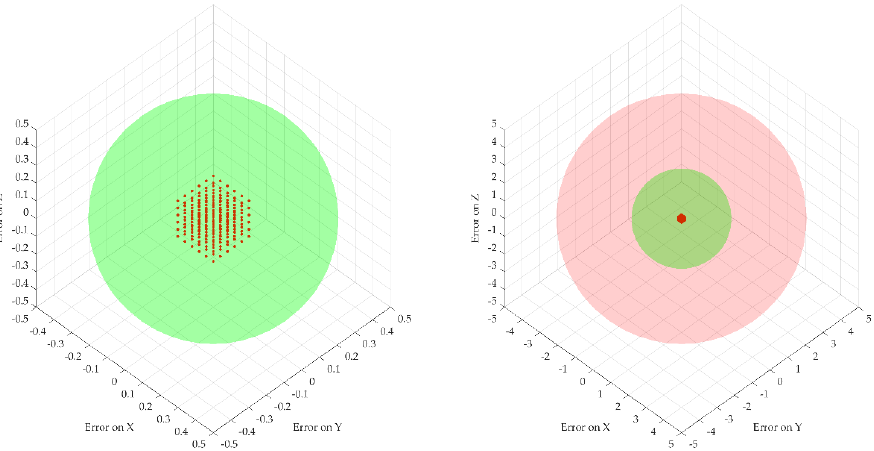
Figure 7. Robot flange positions based on the introduced errors (right, scaled down to [-5 ÷ 5] mm axes scale for comparison with the needle tip data). Figures 7 and 8 illustrate the fact that for a very small dispersion error at the level of the flange, the error for the needle tip exceeds the maximum allowable errors with the increase in the tumor depth. In particular, a random number generator is used to replicate the actual coordinates at the robot flange, adding an inaccuracy to the “theoretical” coor- dinates. This is represented by the point cloud illustrated in Figure 7, where the red dots represent the real possible locations of the robot flange with respect to a single “theoreti- cal” set of coordinates. The real needle tip location is determined with respect to the point cloud created earlier when the insertion is completed at various depths (50, 100, 150 and 200 mm). While the dispersion of the real flange locations is enclosed in a rectangle with sides of 0.2 mm, the resulting error at the needle tip (illustrated graphically in Figure 6) is growing exponentially, reaching up to 5 mm at the depth of 200 mm.